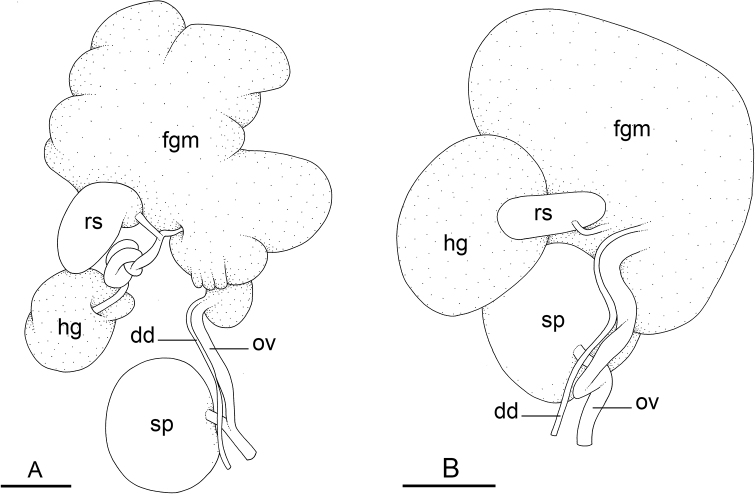
Posterior, hermaphroditic (female) reproductive system, Peronia
sydneyensisA holotype, Australia, New South Wales, [1516 H] (AM C.468916.001) B New Caledonia, [6195] (MNHN-IM-2019-1595). Scale bars: 2 mm (A, B). Abbreviations: dd deferent duct, fgm female gland mass, hg hermaphroditic gland, ov oviduct, rs receptaculum seminis, sp spermatheca